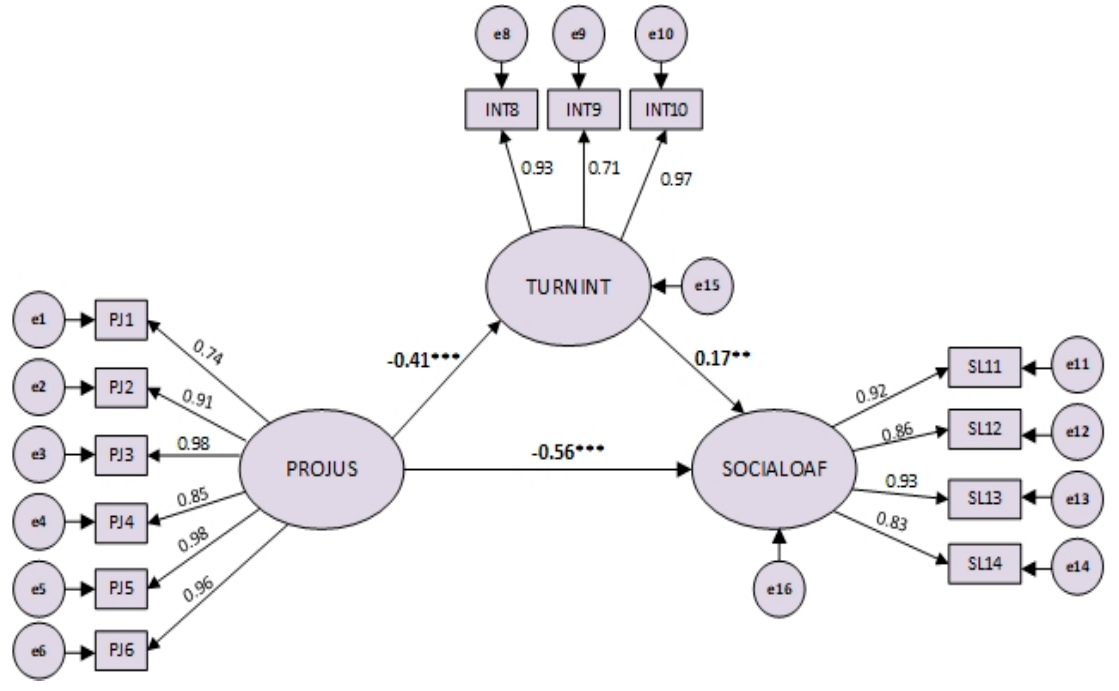
Figure 2. The structural model (** p < 0.01; *** p < 0.001).